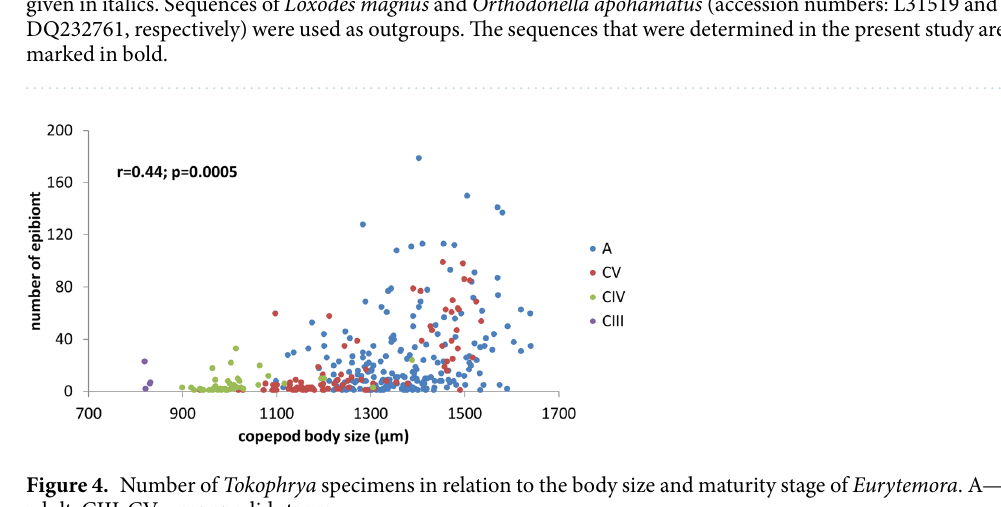
Figure 4. Number of Tokophrya specimens in relation to the body size and maturity stage of Eurytemora . A— adult; CIII-CV—copepodid